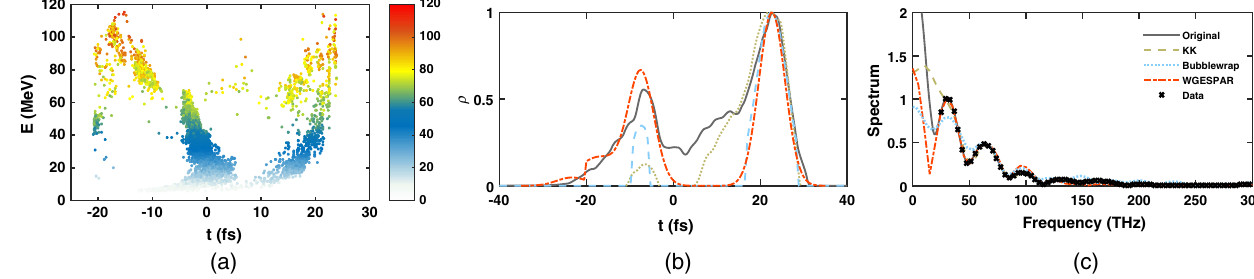
FIG. 5. The longitudinal phase space of the down-ramp injected electrons in the simulation (a) and the comparison of the simulated (gray line) and reconstructed beam current profiles by the WGESPAR algorithm (red dashed line), the KK algorithm (yellow dashed line), and the Bubblewrap algorithm (blue dotted line). The electron current profile (b) is reconstructed from the truncated simulated CTR spectrum (c) in the frequency range of 35 – 350